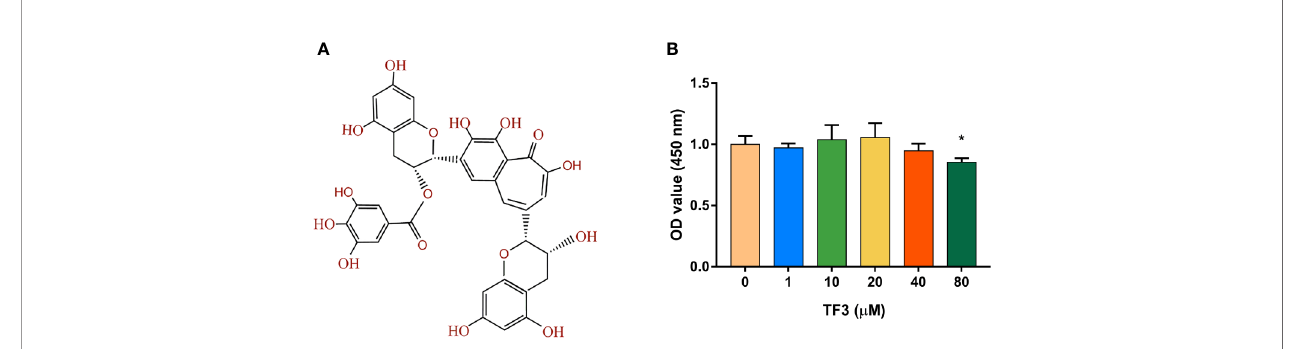
FIGURE 1 | Effects of TF3 on cell viability. (A) The chemical formula of TF3. (B) Cell viability of BMMs treated with various concentrations of TF3 (0, 1, 10, 20, 40, or 80 m M) for 5 days. n = 3, * P < 0.05 compared with control group (without